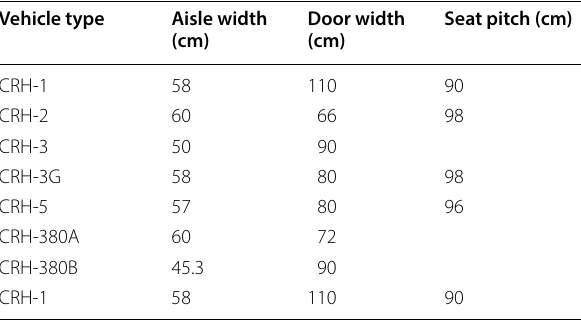
Table 4 Main high-speed second-class space parameters of trains in China Vehicle type